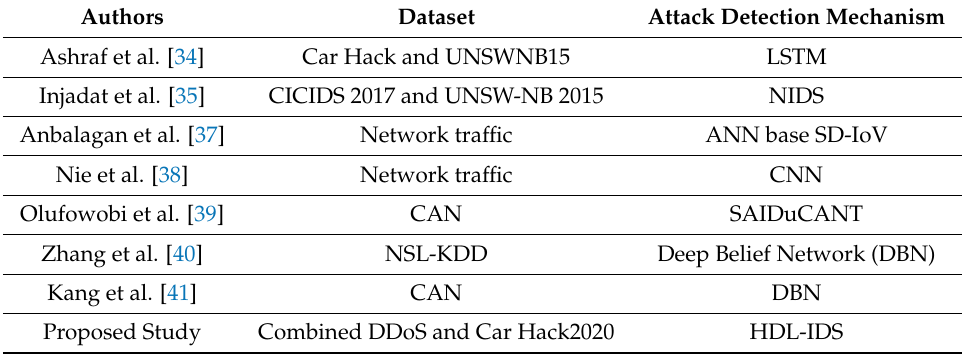
Table 2. Comparison of the HDL-IDS with the state-of-the-art